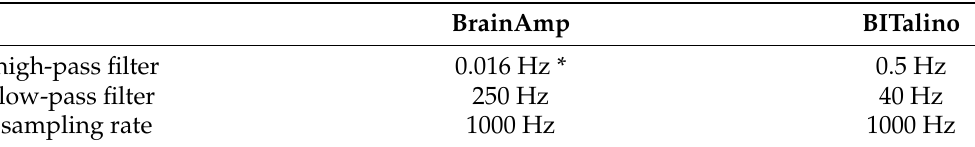
Table 1. Hardware filtering specifications and settings used in the experiment. * Note